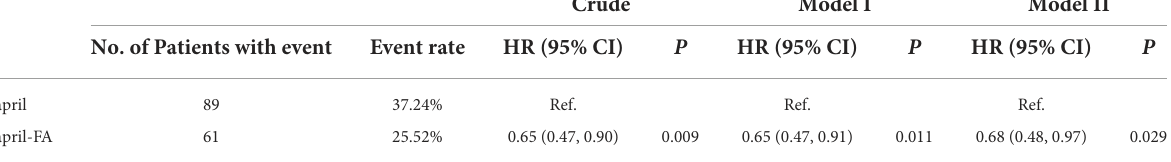
Crude Model I Model II